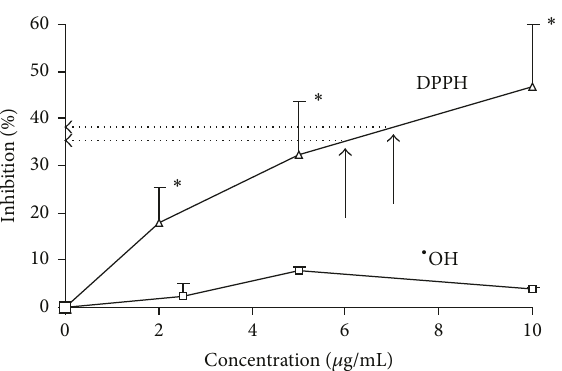
Figure 1: The DPPH and the hydroxyl radical ( ∙ OH ) scavenging activities of ferulic acid. ∗ Value is significantly higher than control (𝑝 < 0.05; 𝑛 = 3) .